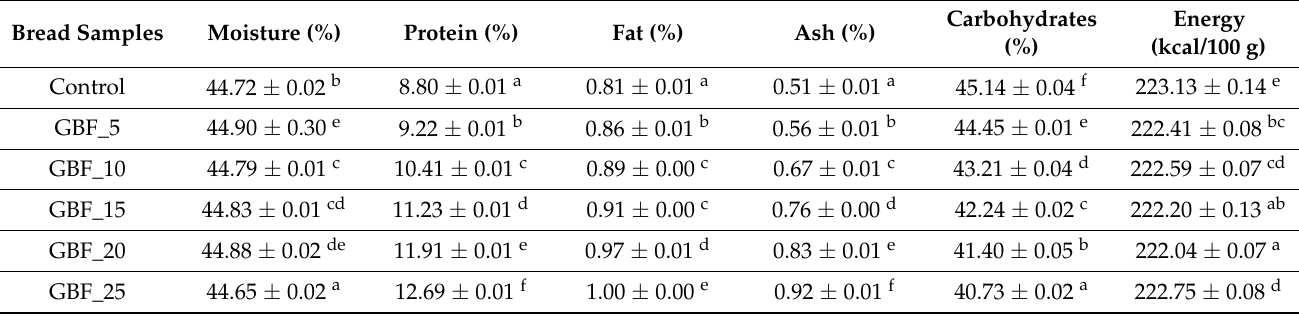
Table 8. Compositional analysis of the bread samples with different levels of germinated bean flour (GBF) additions. Bread